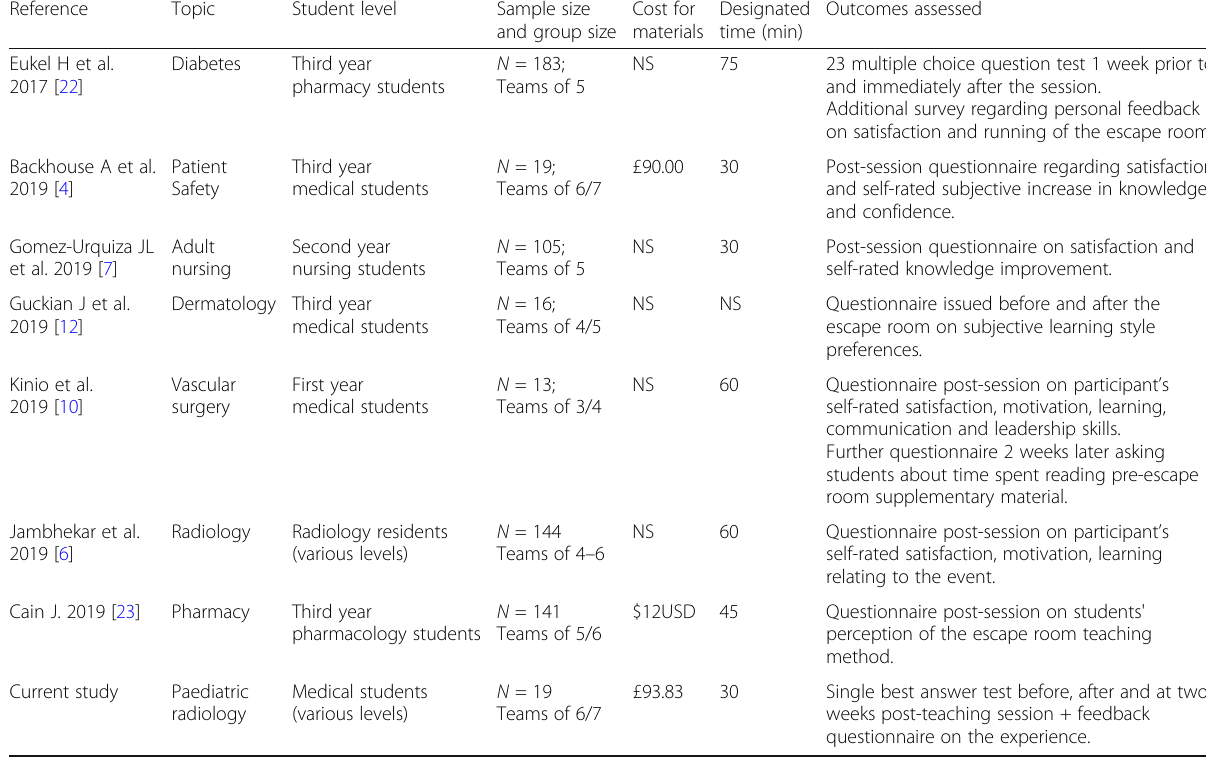
Table 4 Healthcare themed escape rooms published in the literature with a method of outcomes and student demographics